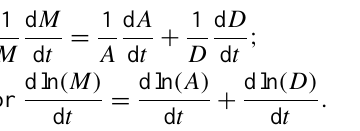
their respective rates of change ( a , d , and m) over time ( t) can be derived from Eqs. (3) and